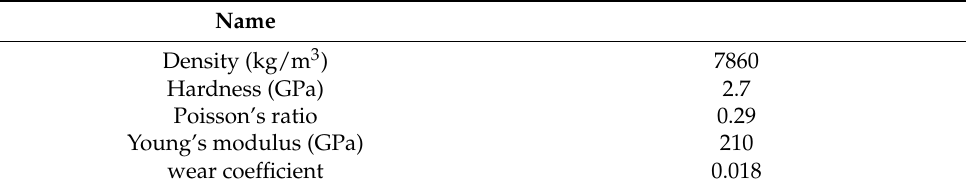
Table 2. Material parameters of the gear pair.